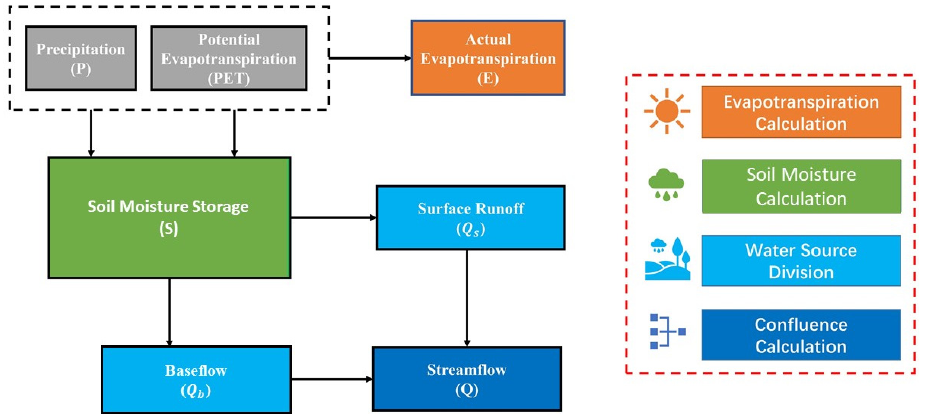
Figure 1. Conceptual diagram of the three-parameter monthly water balance hydrological model.